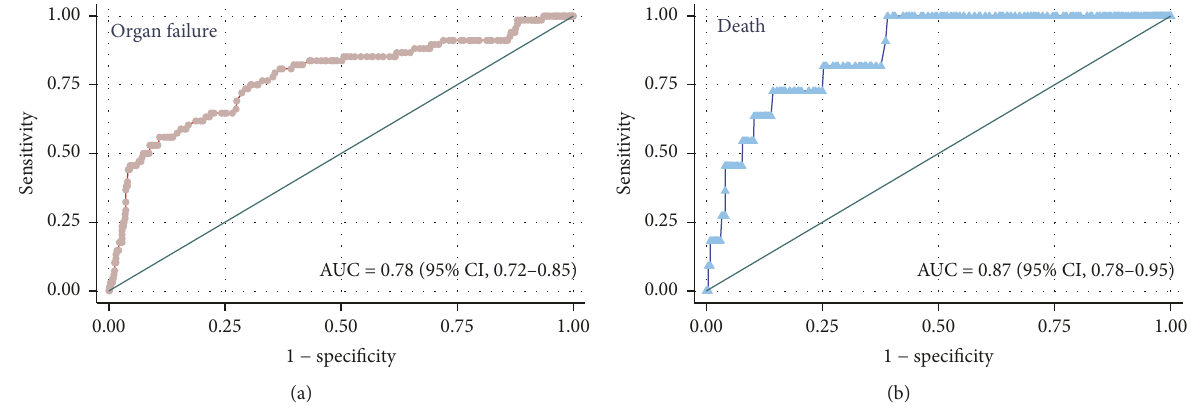
Figure 6: Receiver operating characteristic curves for serum albumin to predict the development of persistent organ failure and occurring of death in acute